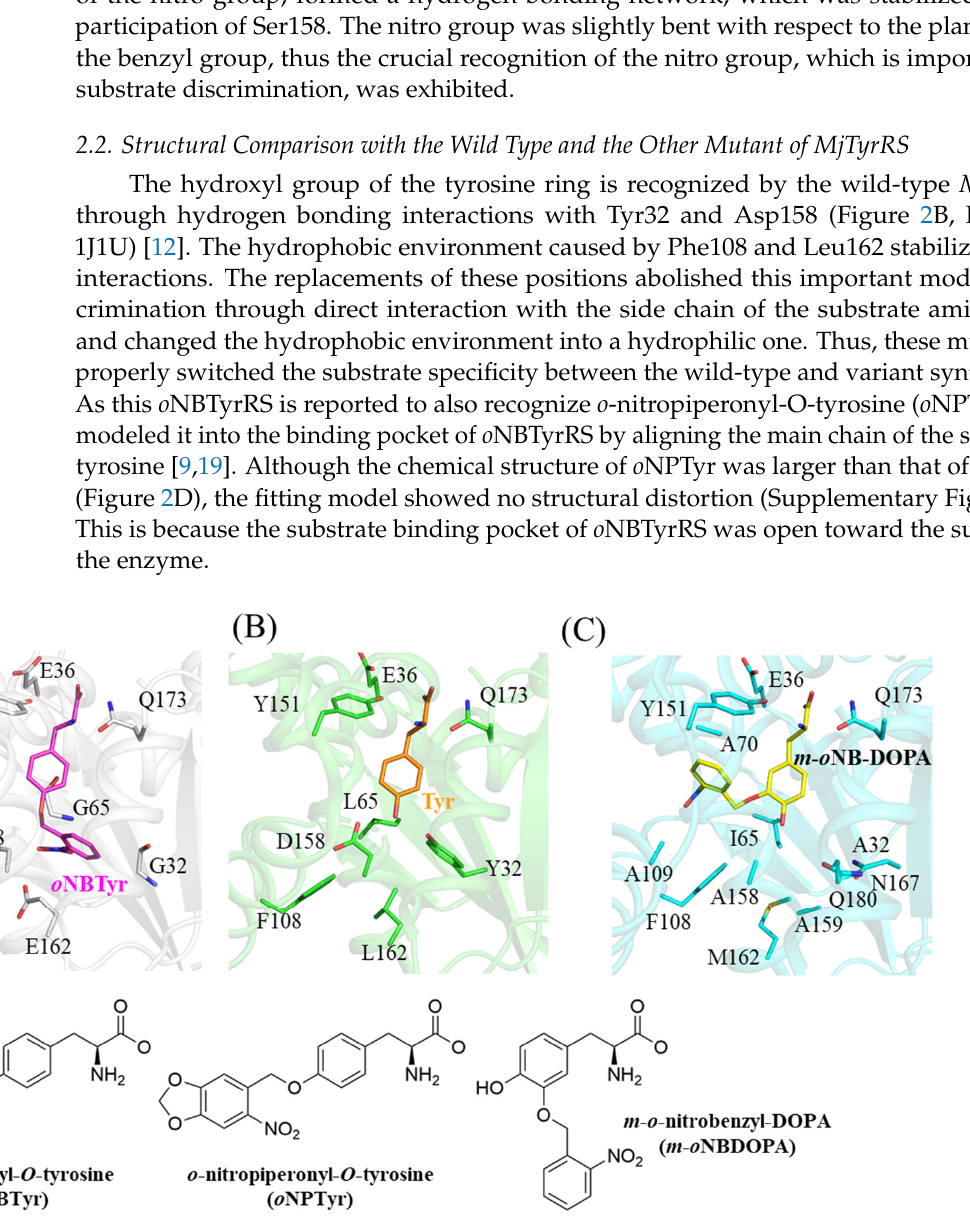
Figure 2. Structural comparison of the substrate binding modes of various Mj TyrRS. Structures of ( A ) o NBTyr in o NBTyrRS (this study); ( B ) tyrosine in the wild-type Mj TyrRS (PDB: 1J1U [12]); ( C ) m-o NBDOPA in the corresponding variant of Mj TyrRS (PDB: 5L7P [8]); ( D ) chemical structures of o NBTyr, o NPTyr, and m - o NB-DOPA.